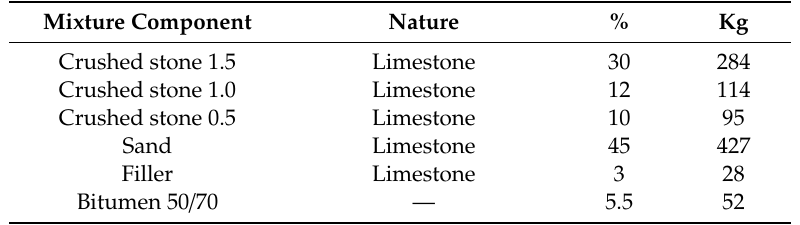
Table 3. Composition of a DU of asphalt mixture (1 ton), according to the mix-design.